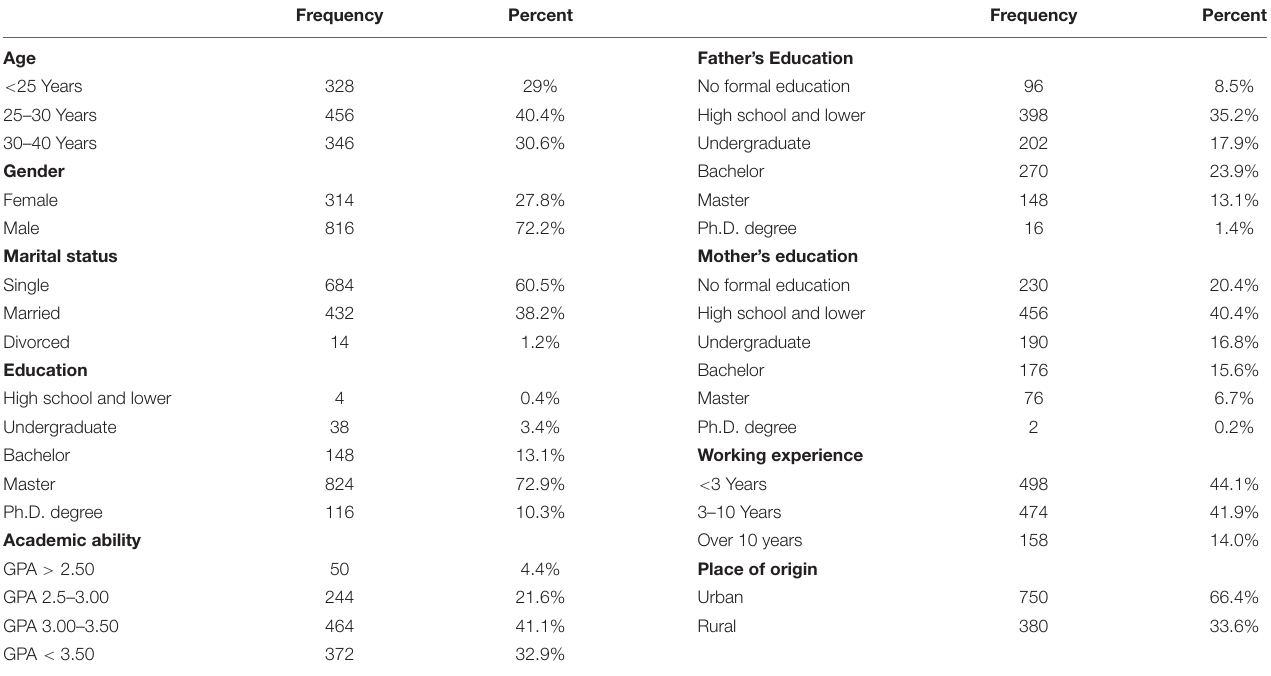
TABLE 1 | Demographic profile of the